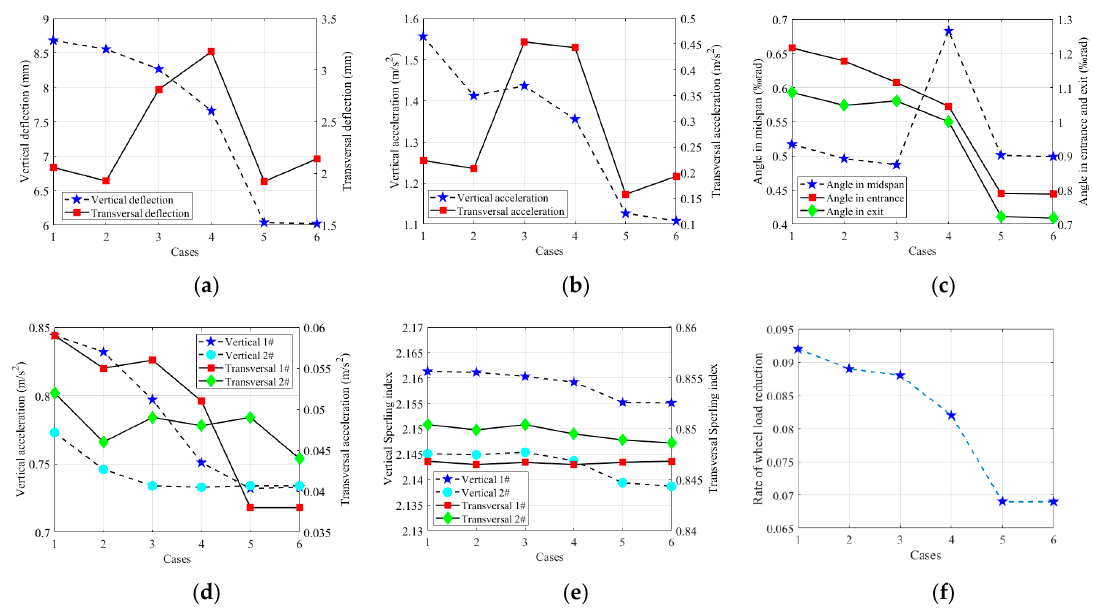
Figure 14. Responses of the bridge and the train under different improvement cases—( a ) bridge deflection, ( b ) bridge acceleration, ( c ) bridge angle, ( d ) train acceleration, ( e ) Sperling index, and ( f ) rate of wheel load reduction.